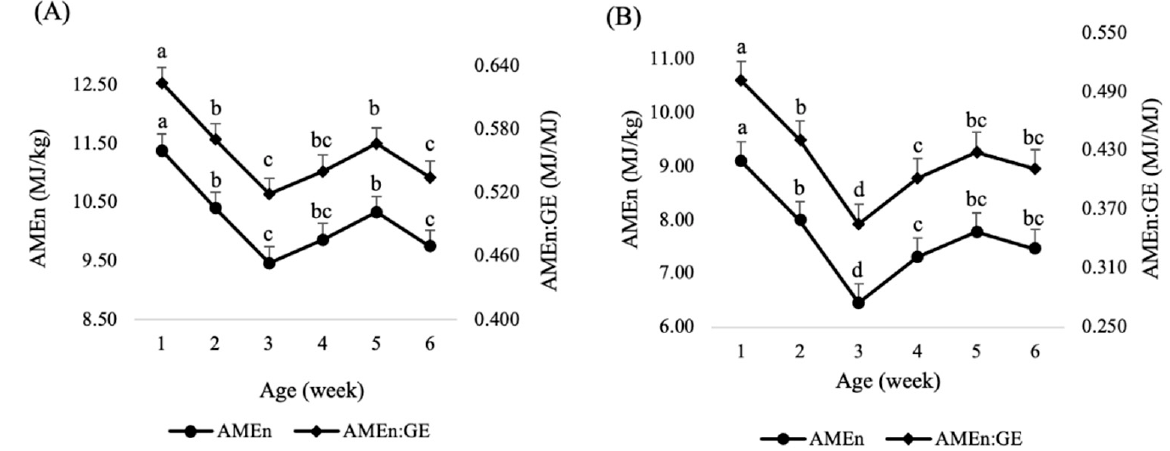
Figure 1. Effect of broiler age on the nitrogen-corrected apparent metabolizable energy (AMEn) and the ratio between AMEn and gross energy (AMEn:GE) for soybean meal ( A ) and canola meal ( B ); mean ± standard error. a–d Values with different superscripts differ significantly ( p < 0.05). The retention of DM and N, AME and AMEn and AMEn:GE of CM measured at different ages of broiler chickens are presented in Table 4. The DM retention of CM showed a quadratic decrease ( p < 0.001) as birds grew older. Birds retained the highest DM in week 1, decreased to week 2, plateaued between weeks 3 and 5, and declined further in week 6. For N retention, birds retained 66.3% N in week 1, which decreased linearly ( p < 0.001) to 48.1% in week 6. The AME, AMEn and AMEn:GE of CM decreased quadratically ( p < 0.001) with advancing age (Figure 1B). The AMEn of CM decreased from 9.10 MJ/kg in week 1 to